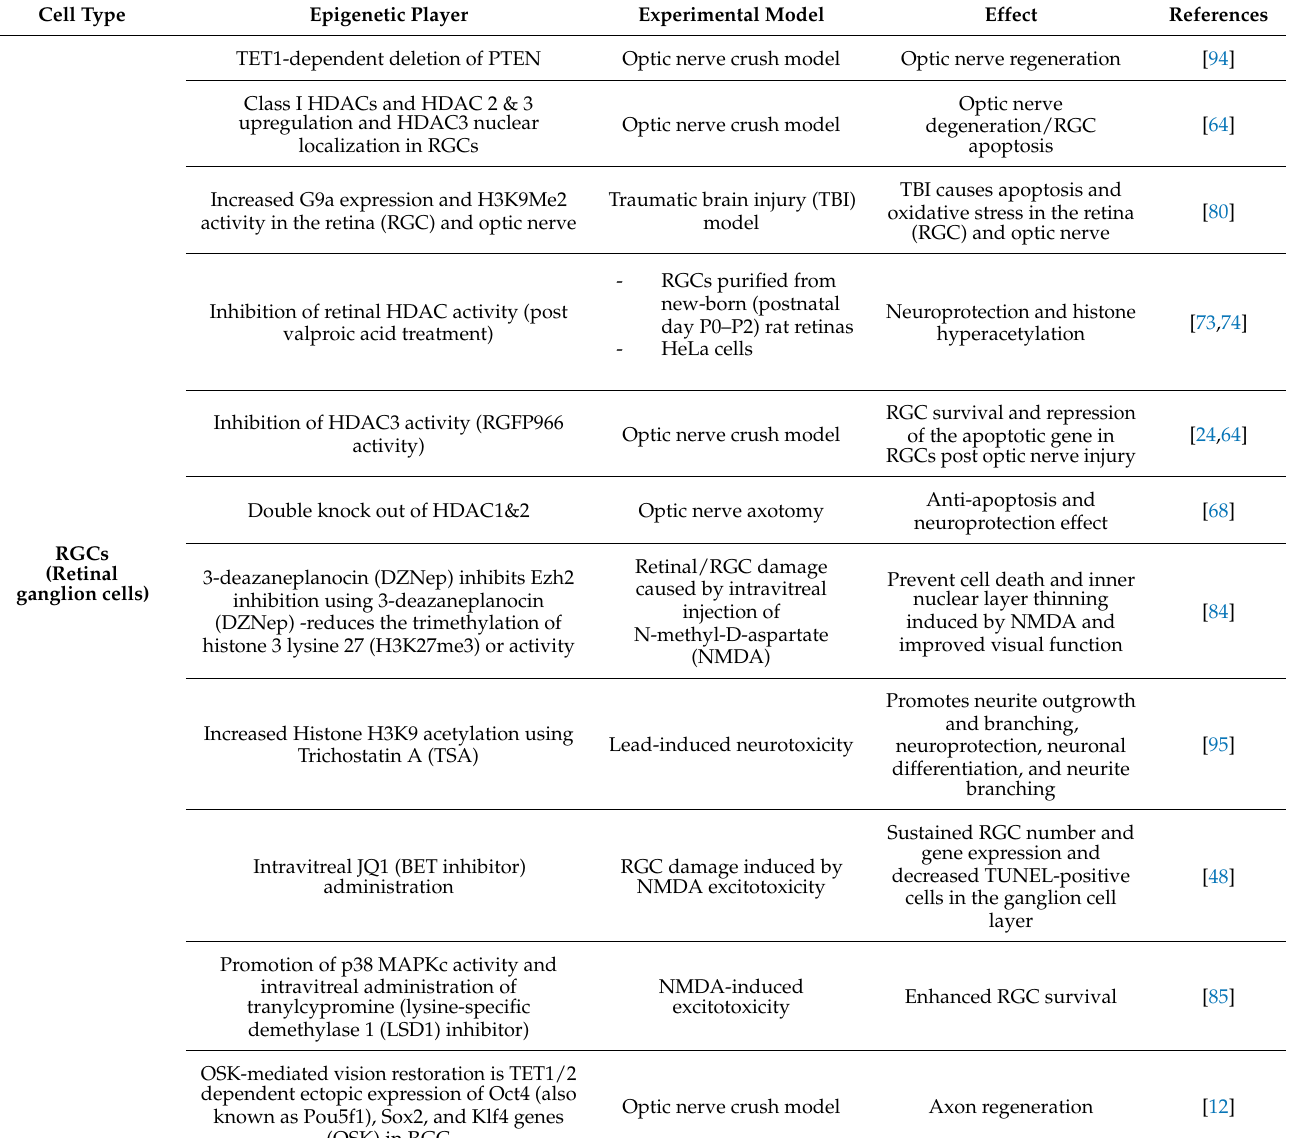
Table 1. Epigenetic Studies in Optic Nerve